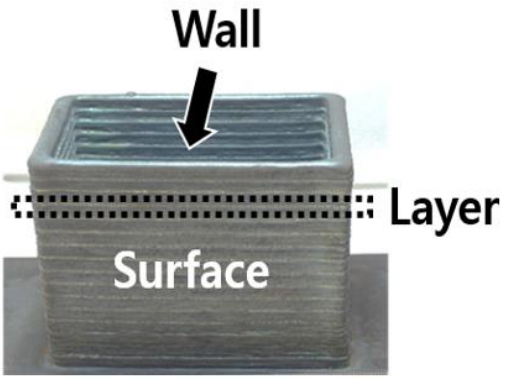
Figure 1. Surface roughness of WAAM product.